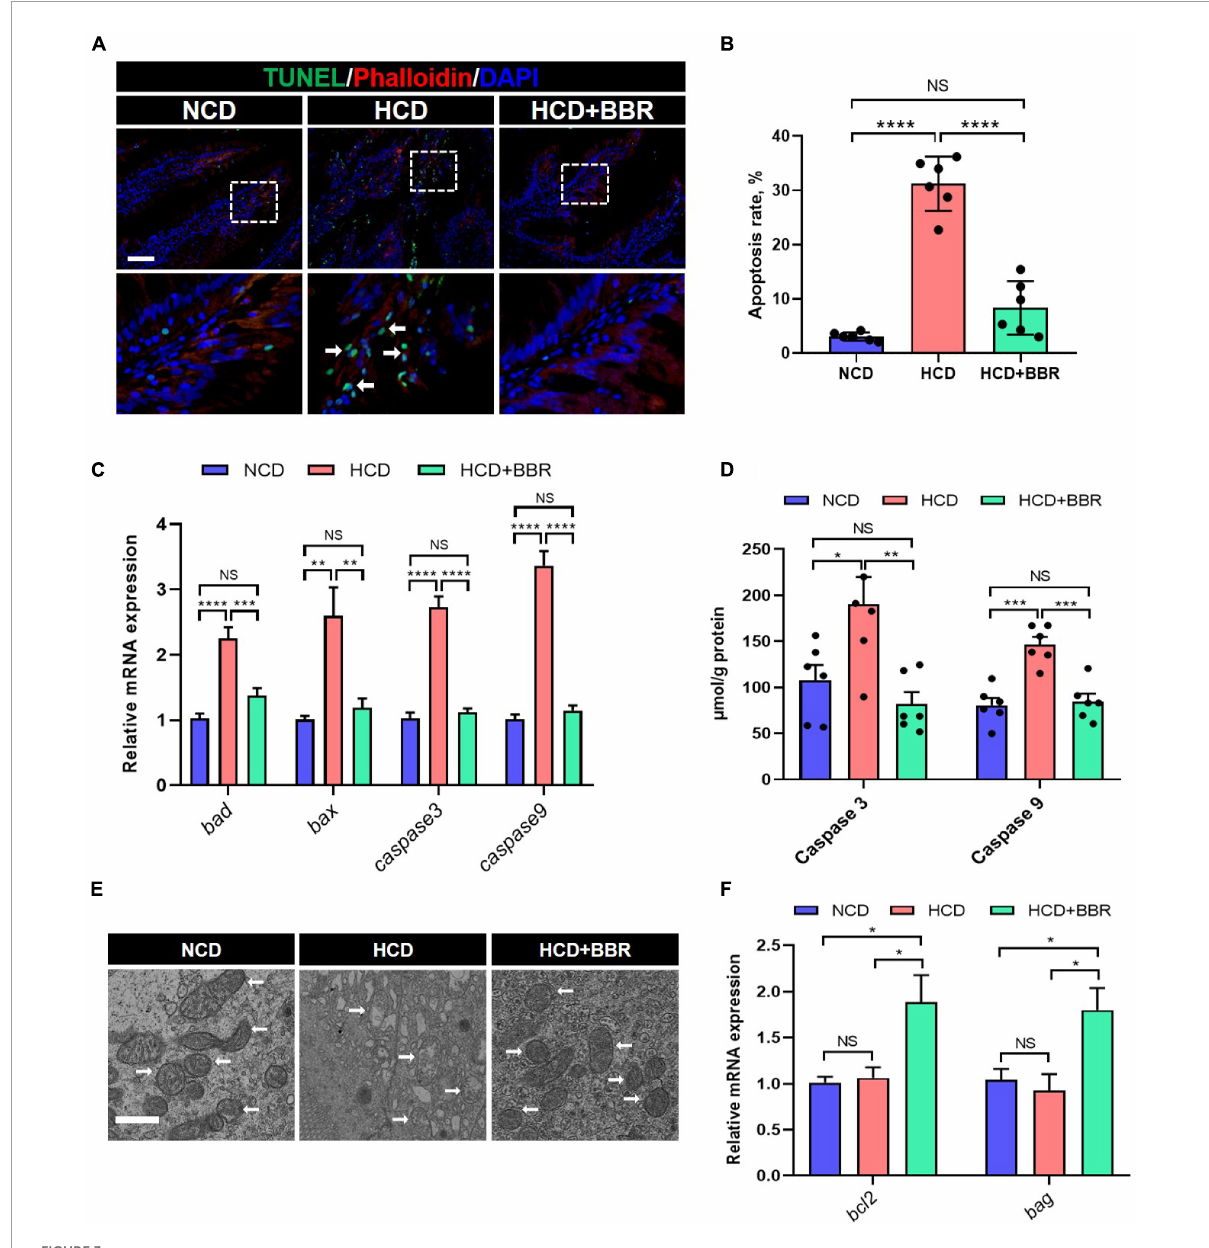
FIGURE3 Dietary BBR suppressed the HCD-induced apoptosis in the intestine of largemouth bass. (A) TUNEL (green) staining images of intestinal sections (arrows indicate TUNEL signal, bar = 50 µ m). (B) Apoptosis rate in intestinal sections. (C) Expression level of proapoptotic genes. (D) Intestinal Caspase 3 and Caspase 9 level. (E) Transmission electron microscope images of intestinal mitochondria (arrows indicate mitochondria, bar = 1 µ m). (F) Expression level of anti-apoptotic genes. Data are represented as means ± SEM ( n = 6). *, **, ***, ****Different from each other: * P < 0.05, ** P < 0.01, *** P < 0.001, **** P < 0.0001, NS means no significant difference (One-way ANOVA, Duncan’s post hoc